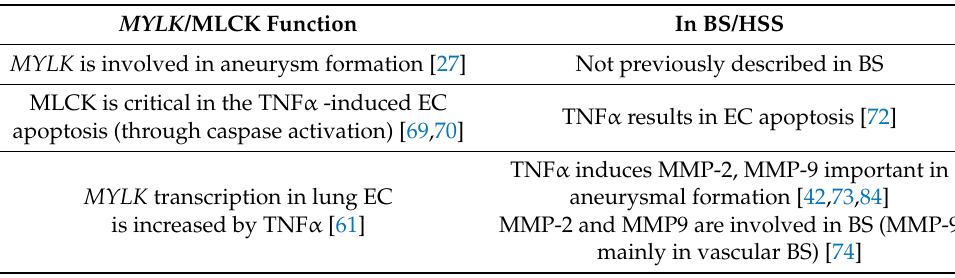
Table 1. MYLK effects and possible pathogenetic involvement in